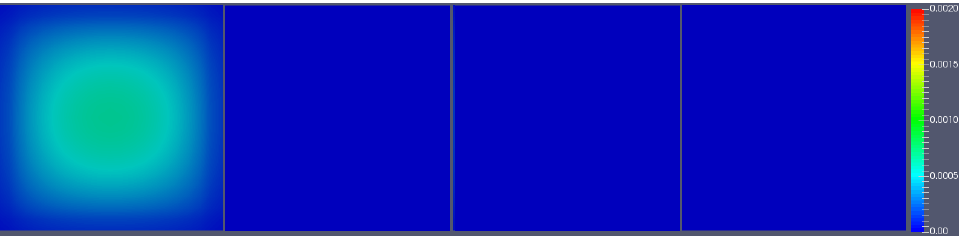
Figure 7. Patterns of water distribution over grain for 8 min, 16 min, 24 min and 32